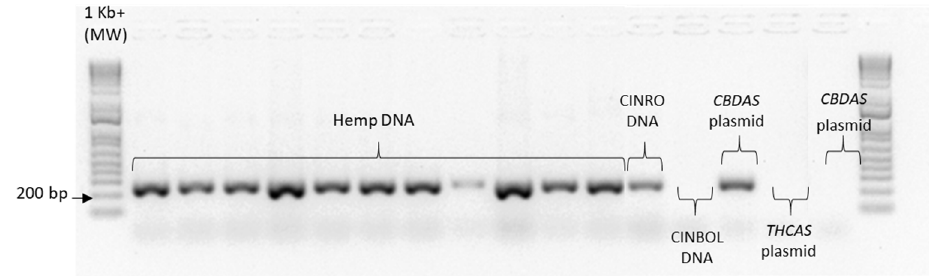
Figure A3. Specificity of primers for CBCAS genes. The expected amplification band of 198 bp was obtained from pJET1.2 containing the CBCAS and DNA of all tested genotypes. Amplification was not obtained from pJET1.2 plasmid containing the THCAS and the CBDAS , indicating a great specificity of this primer pairs.